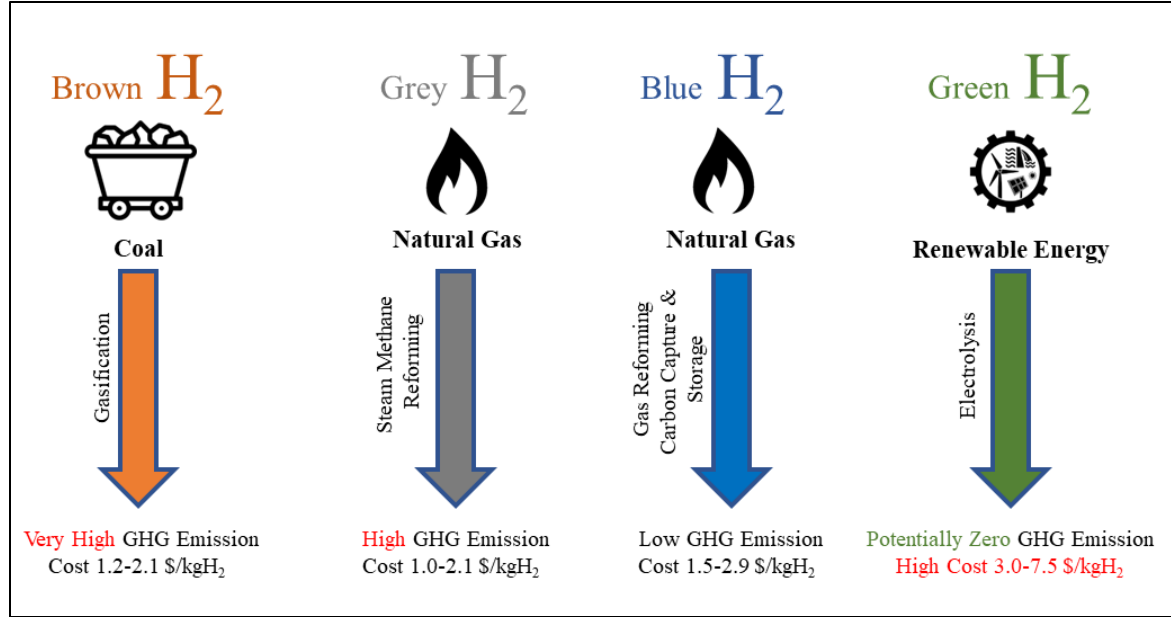
Figure 2. Colours of Hydrogen .